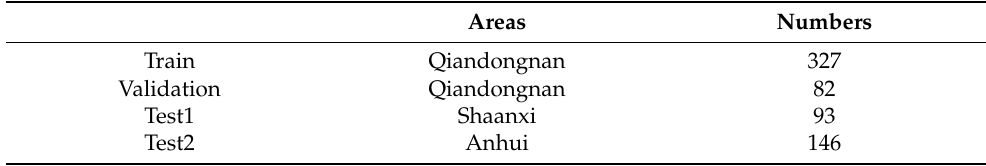
Table 3. Splitting the TCS environmental pattern dataset.